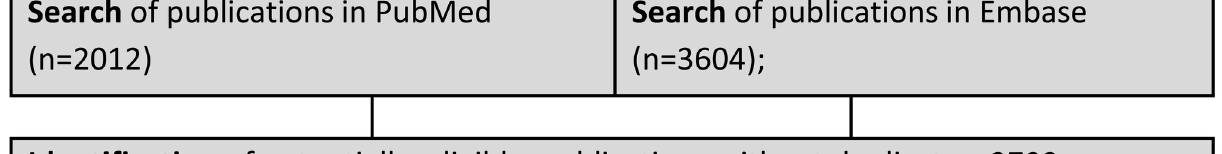
Short summary of the review: Early studies from the US (26) and Jordan (27) showed no detrimental effect of dust exposure